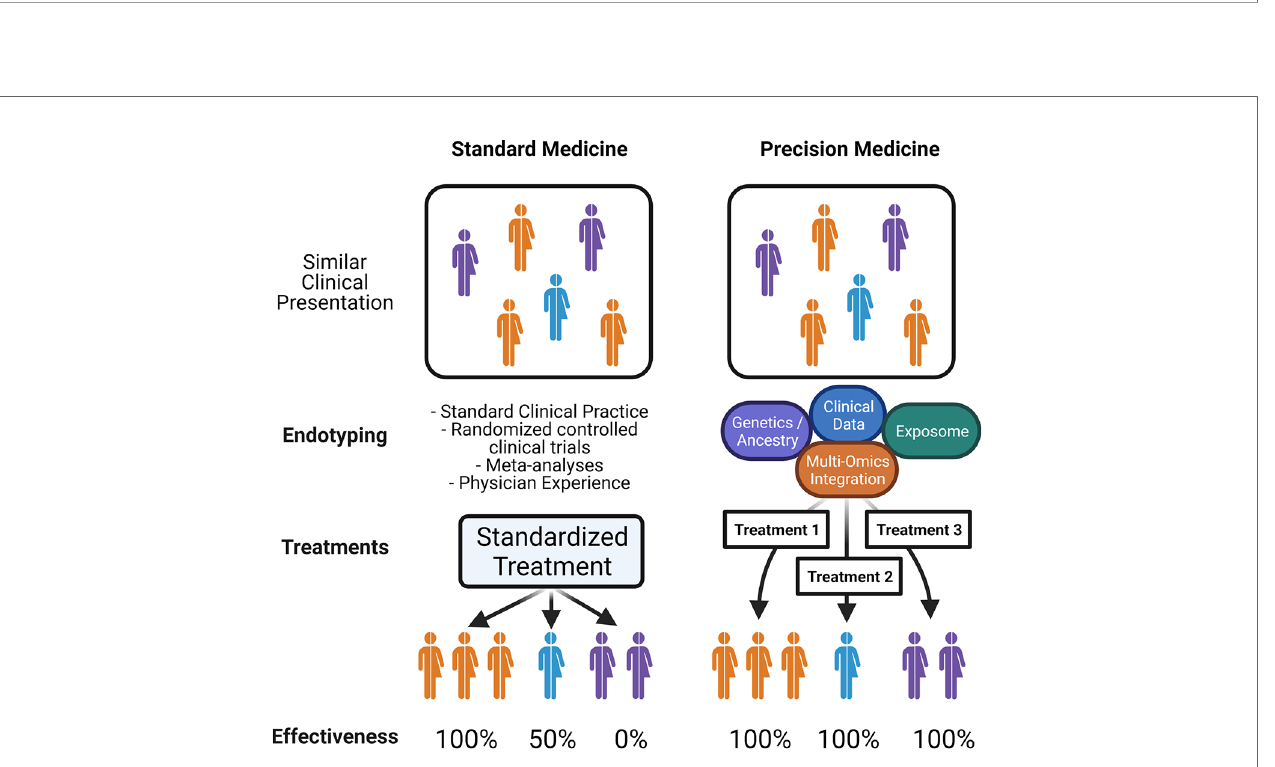
FIGURE 2 | Precision Medicine in Allergy: Schematic illustrates; on the left, standard medical practice relies on clinical presentation or phenotypes, leading to limited endotypic classi fi cation, and standardized therapy which may be effective for only a subset of patients. On the right, an idealized precision medicine approach which takes into account all patient-speci fi c data that reveals endotypes with common molecular pathways, in order to match patients with tailored treatments that have increased effectiveness.